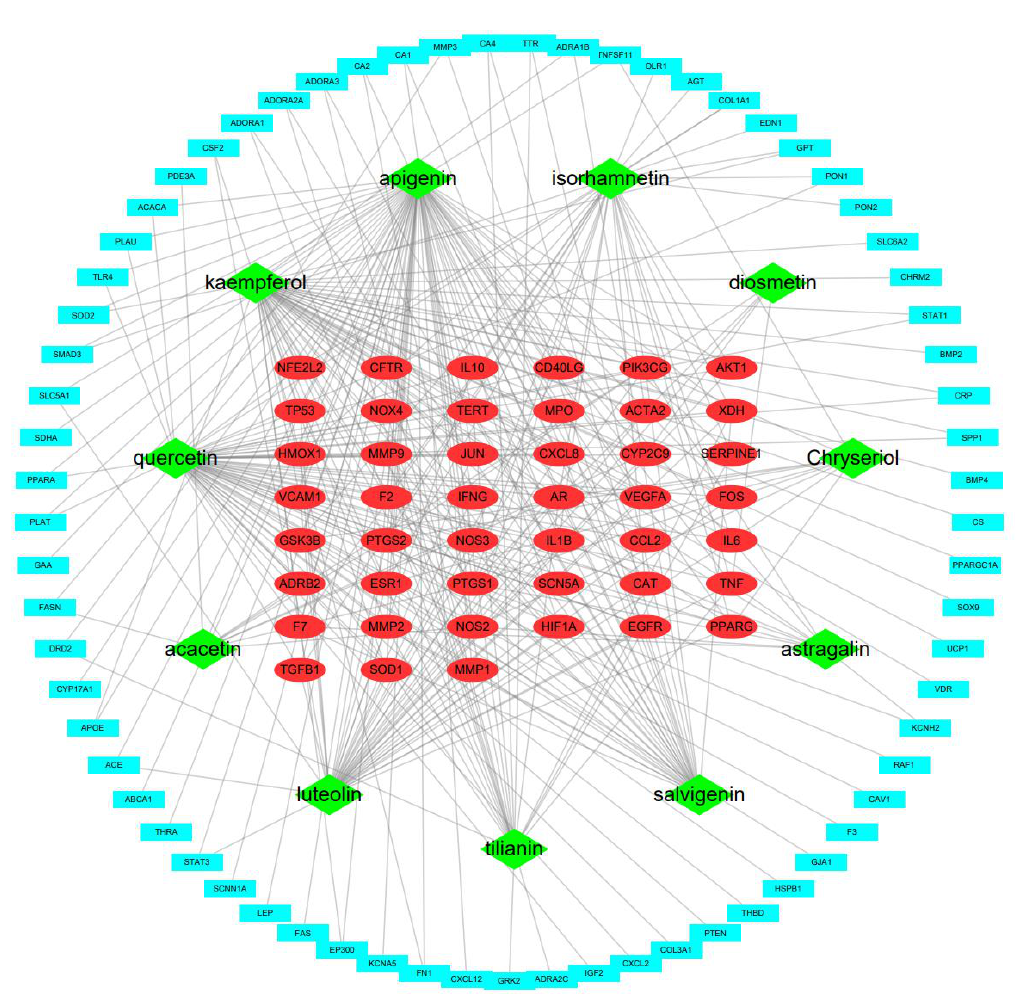
Figure 3. The compound–target network. Green diamonds represent compounds, red ellipses represent targets whose degree is greater than or equal to three, and blue rectangles represent targets whose degree is less than or equal to two. Table 3. The top 10 hub genes with higher degree of connectivity.